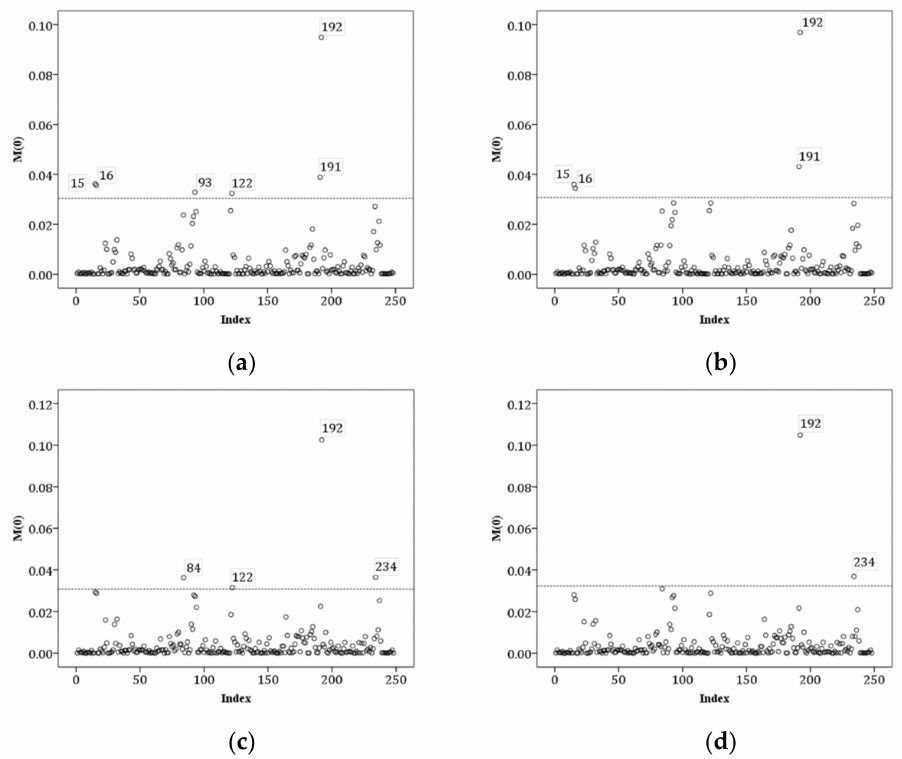
Figure 5. Index plots of M (0) for the perturbation of the first column of X for the four scenarios. Dotted lines show the yardstick for M (0) with c ∗ = 3.